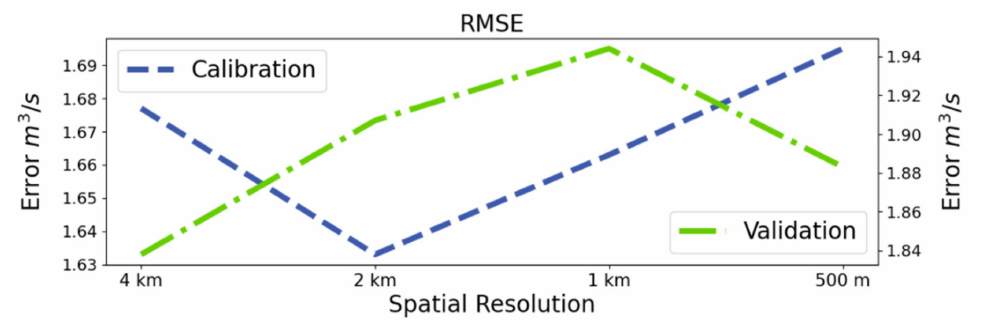
Figure 15. RMSE values of FW-1-D during calibration and validation periods.